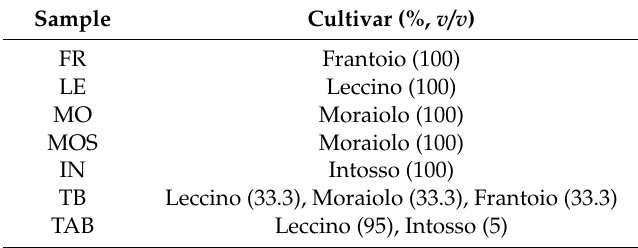
Table 1. EVOOs samples.